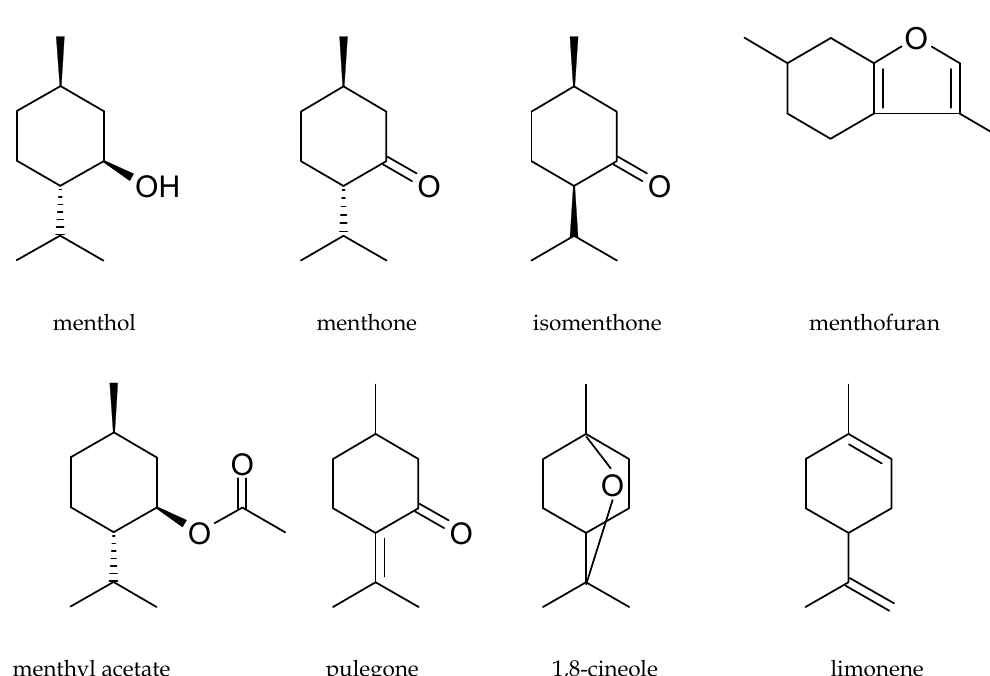
Figure 1. Structures of the main components of menthol mint essential oils.